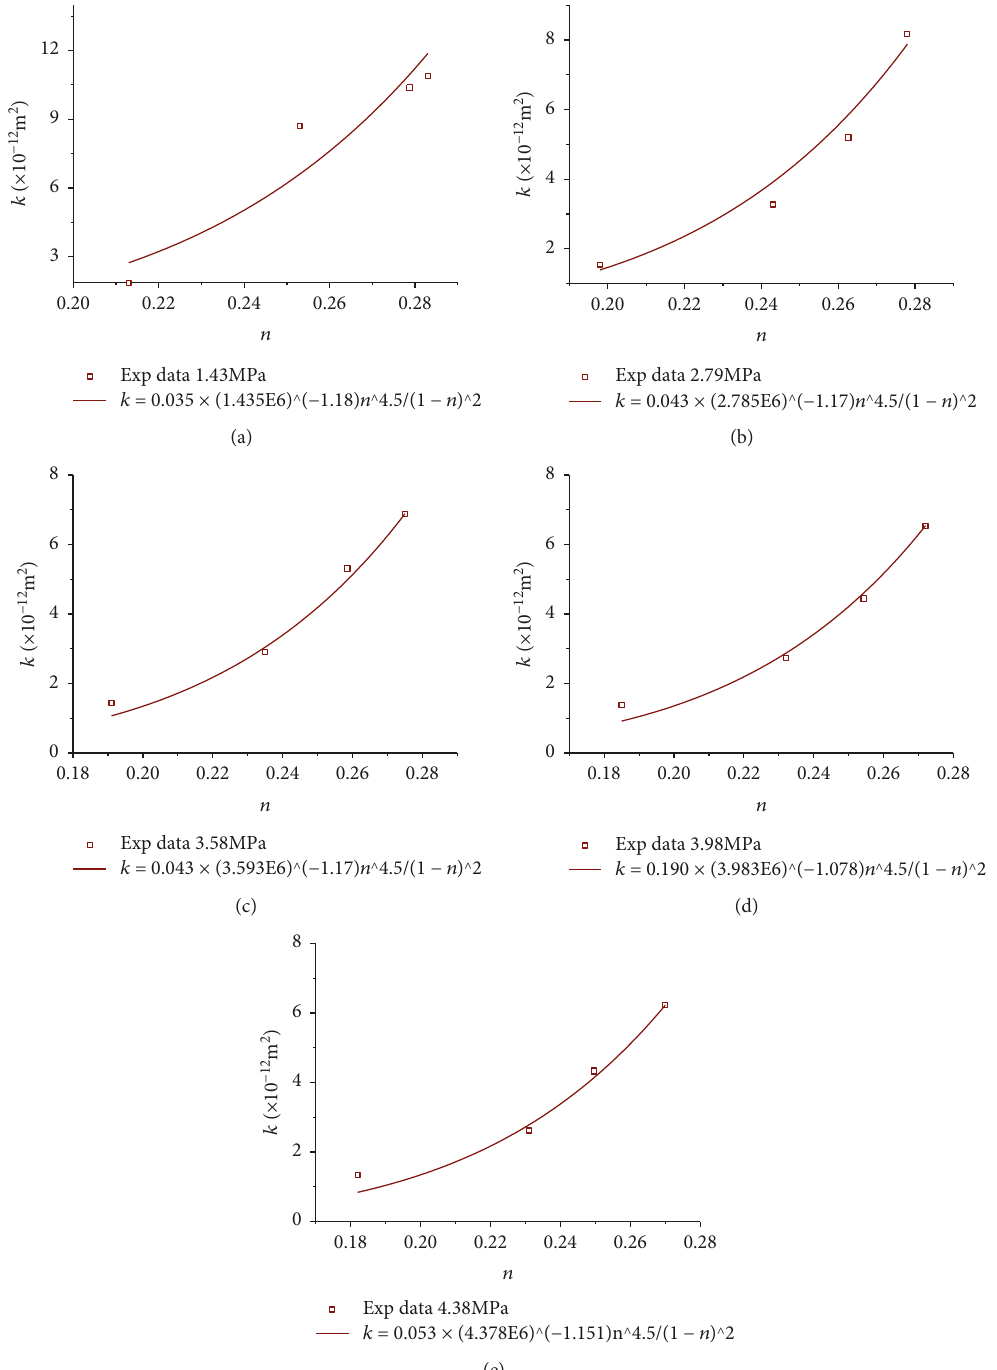
Figure 6: Intrinsic permeability characteristic with the in fl uence of initial porosity under di ff erent